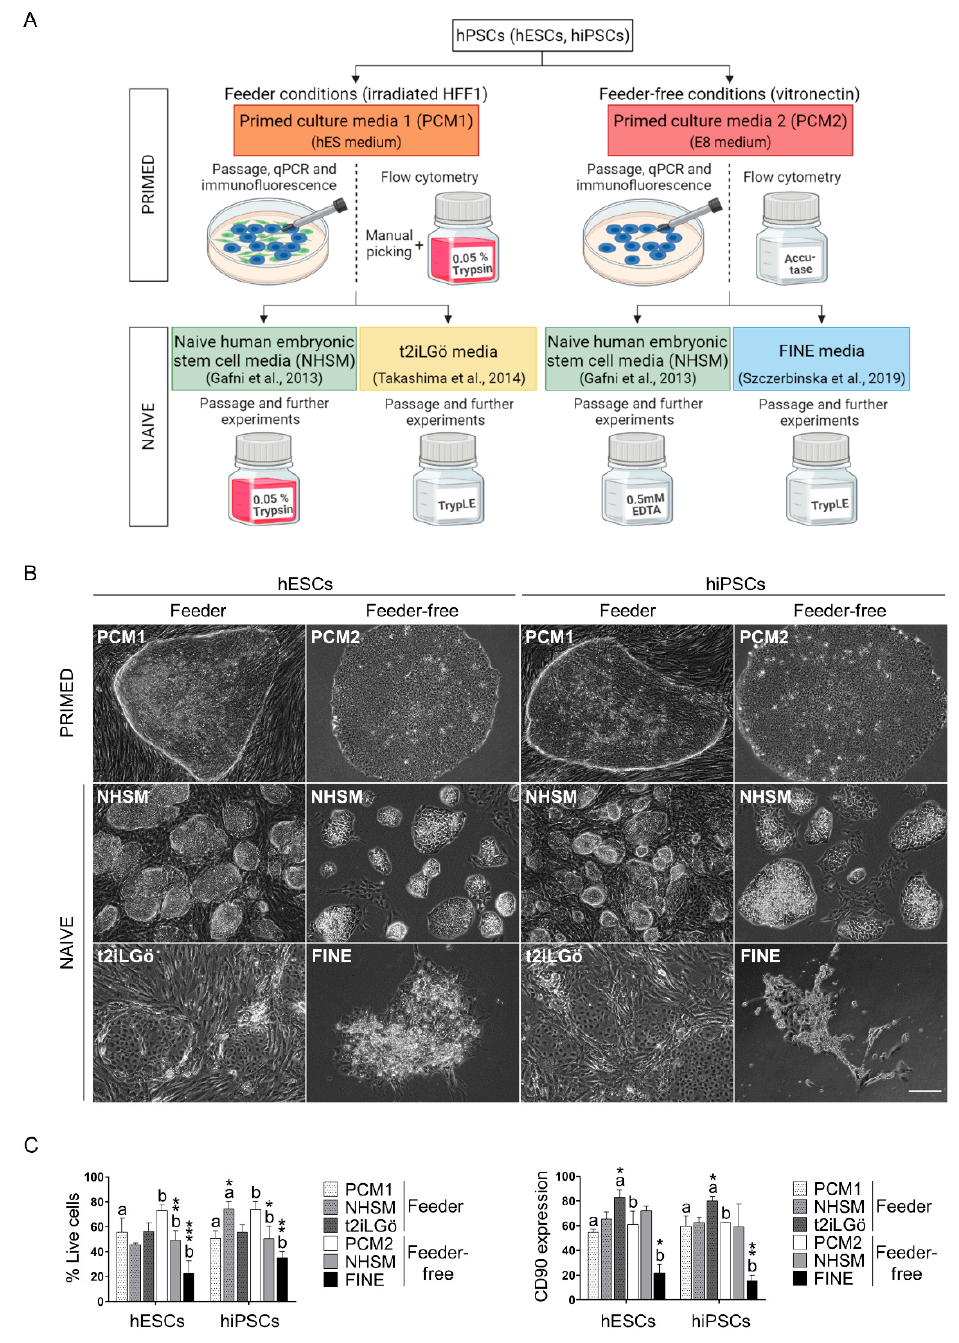
Figure 1. Conversion of primed hPSCs (hESCs, hiPSCs) toward a naive state in different culture media conditions. ( A ) Overview of primed to naive conversion protocol in the feeder and feeder-free culture systems. In feeder conditions, primed hPSCs were maintained in PCM1 (hES medium). Passages and cells used for qRT-PCR and immunofluorescence analysis were mechanically picked up. For flow cytometry assay, cell colonies were disaggregated using 0.05% trypsin following manual picking. Finally, feeder primed hPSCs were cultured in NHSM or t2iLGö media for the primed to naive transition, and cell detachment was performed by 0.05% trypsin and TrypLE solution, respectively. In feeder-free conditions, primed hPSCs were cultured in PCM2 (E8 medium). Colonial cell disaggregation was performed by manual picking in all procedures, except inflow cytometry workflow, in which Accutase solution was used. Lastly, feeder-free primed hPSCs were maintained in NHSM or FINE media for naive conversion, and cells were detached with 0.5 mM EDTA and TrypLE solution, respectively. ( B ) Morphological differences between primed and naive hPSCs colonies in different culture media conditions. Scale bar, 200 μ m. ( C ) Flow cytometry